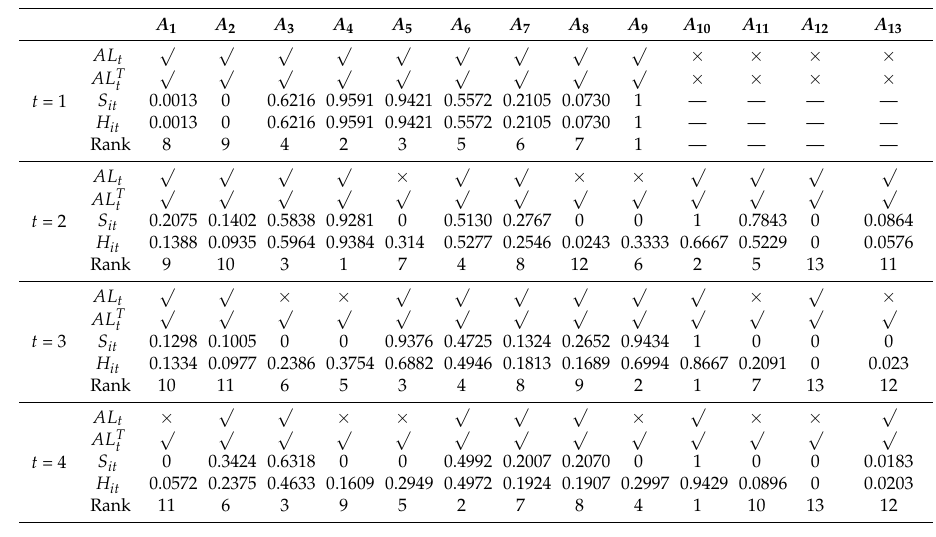
Table 8. The final scores and ranks of alternatives at each